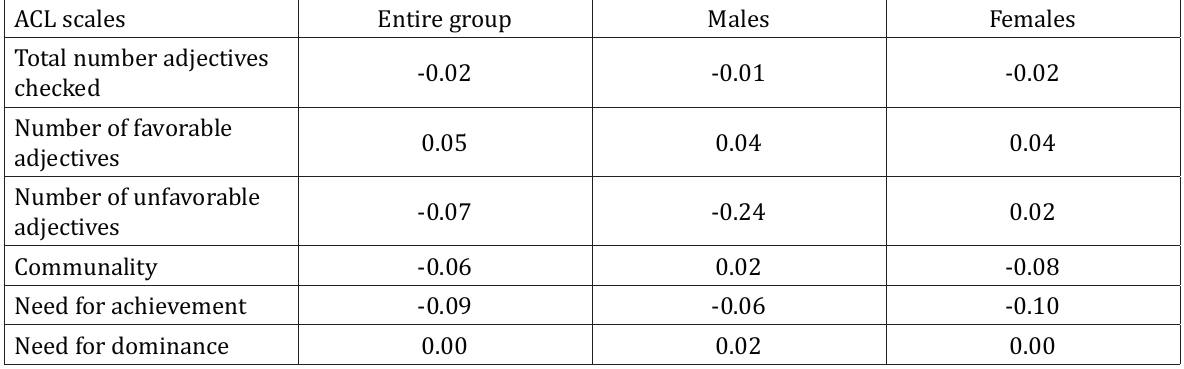
Table 2. Correlation coefficients between the participants' daily SNS usage times and their ACL scores